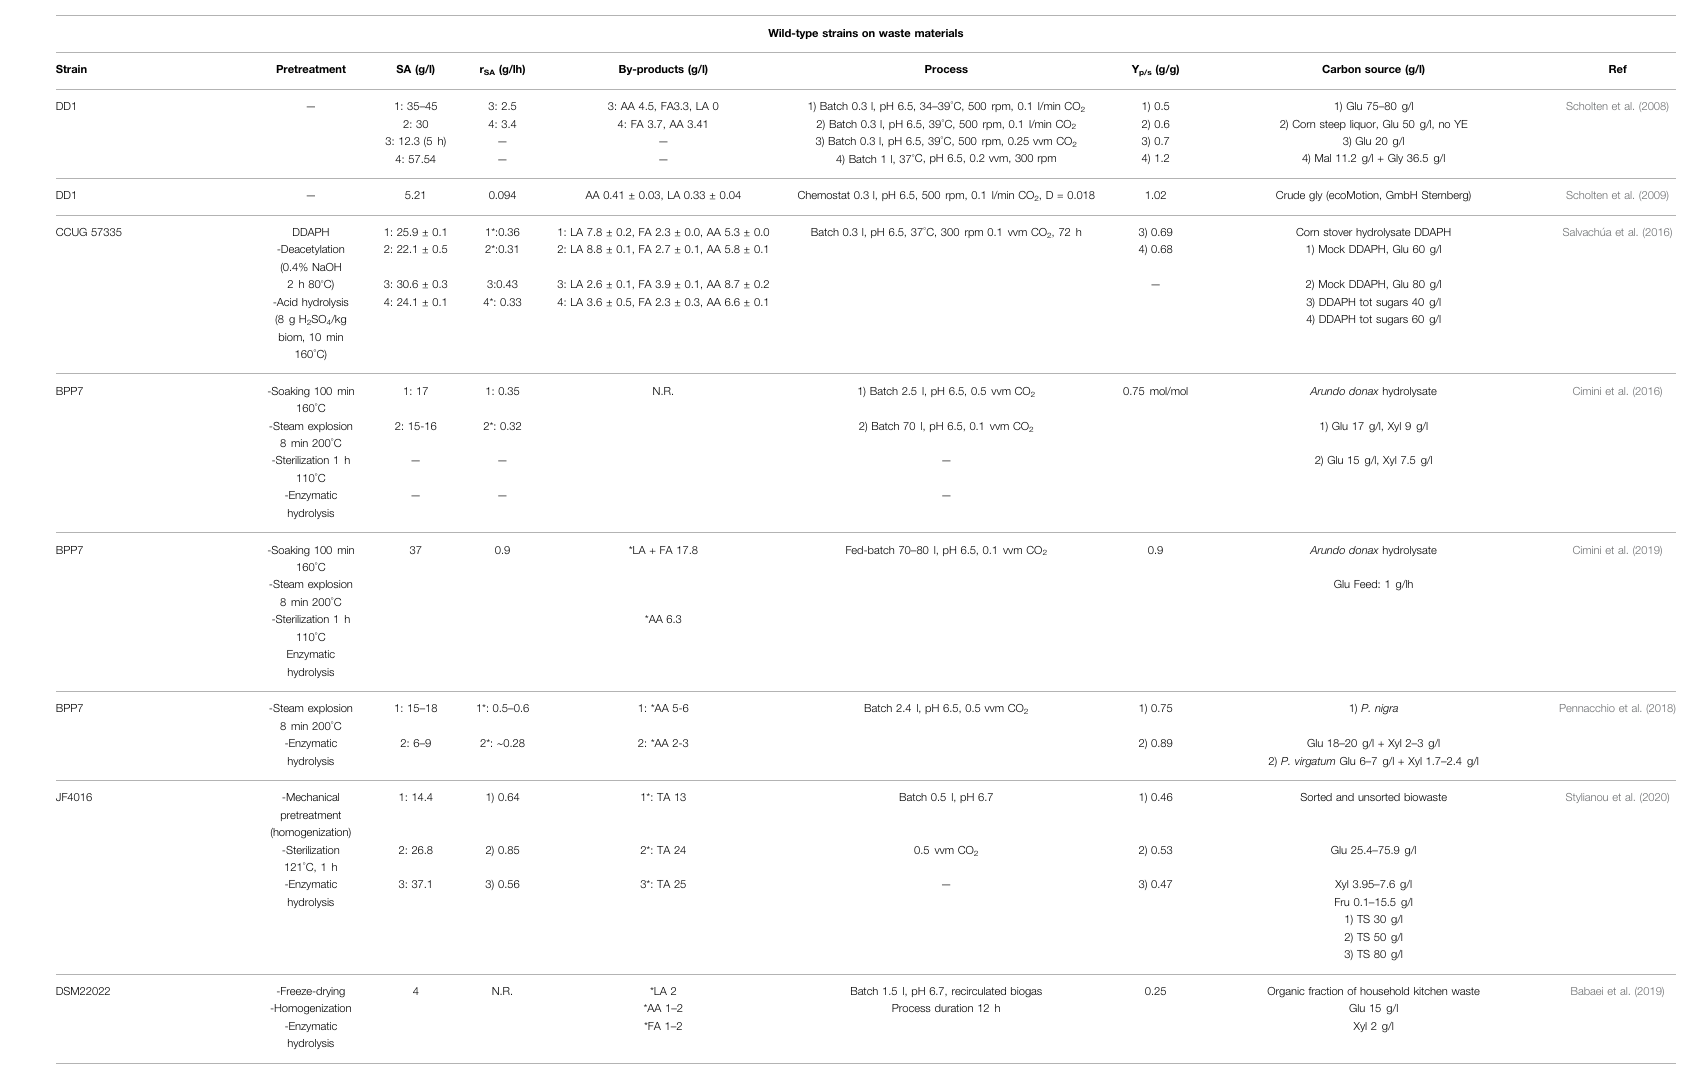
TABLE 1 | ( Continued ) Engineering and fermentation strategies used to improve succinic acid production in B. succiniciproducens and fermentation processes developed for the production of succinic acid from wild-type B. succiniciproducens spp. on renewable materials. N.R., not reported. TA, total acid by-products; Glu, glucose; Gly, glycerol; Suc, sucrose; Mal, maltose; DDAPH, deacetylated dilute acid-pretreated hydrolysate; Xyl, xylose; Fru, fructose; TS, total sugars; SSL, spent sul fi te liquor; LS, lignosulfonates. *indicates values deduced from graphs reported in the relative publication or calculated from the yields. Batch: closed process in which all nutrients areaddedattimezeroandallproductsremaininthebioreactoruntiltheendoftherun;Fed-batch, semi-openprocess,inwhichafterabatchphasenutrientsarefedtoprolongthegrowthphase,andallproductsremaininthe bioreactor until the end of the run; Chemostat, open process in which nutrients are continuously added to the reactor and products (and unconsumed nutrients) are removed at the same rate to keep the volume